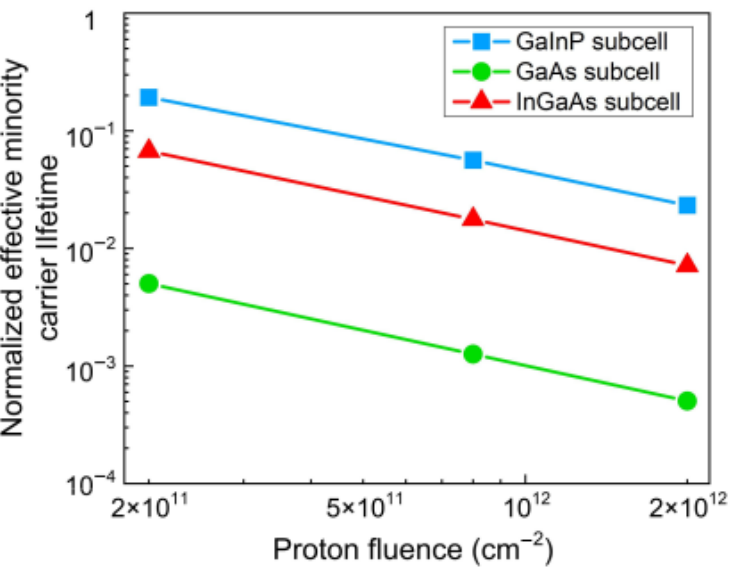
Figure 4. Normalized minority carrier lifetime of each subcell of IMM3J solar cells as a function of irradiation